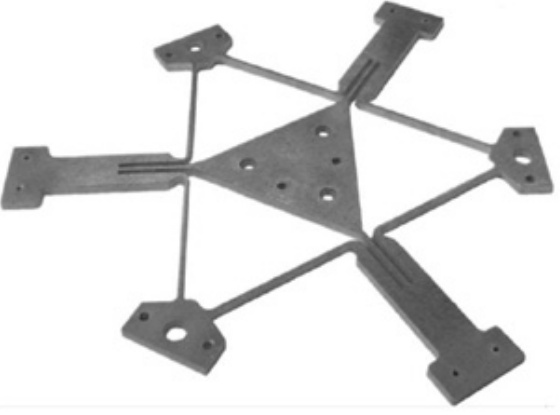
Figure 6. Typically example of a planar compliant stage (Ander- son, 2003; Culpepper, 2006; Culpepper and Anderson, 2004). The flexures to perfom motion are in the same